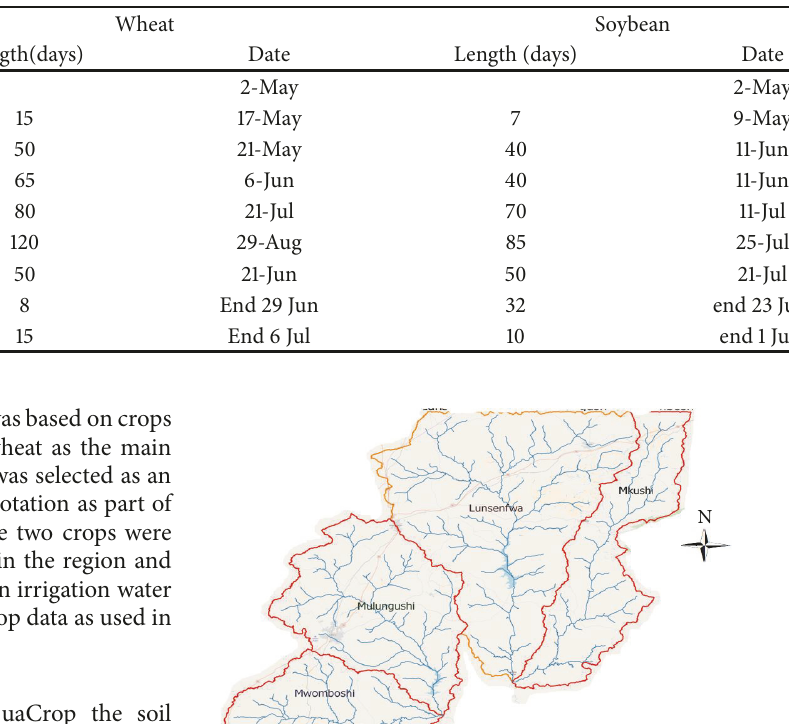
Table 2: Crop parameters used in AquaCrop.